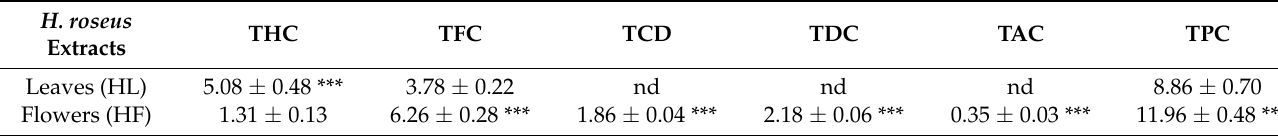
Table 2. Quantification of phenolics (mg g − 1 dry weight, DW) in Hibiscus roseus leaf (HL) and flower (HF) extracts. TFC: total flavonoid content; THC: total hydroxycinnamic acid derivatives content; TCD: total catechin derivatives content; TDC: total dihydrochalcones content; TAC: total anthocyanins content; TPC: total phenolic content. H.